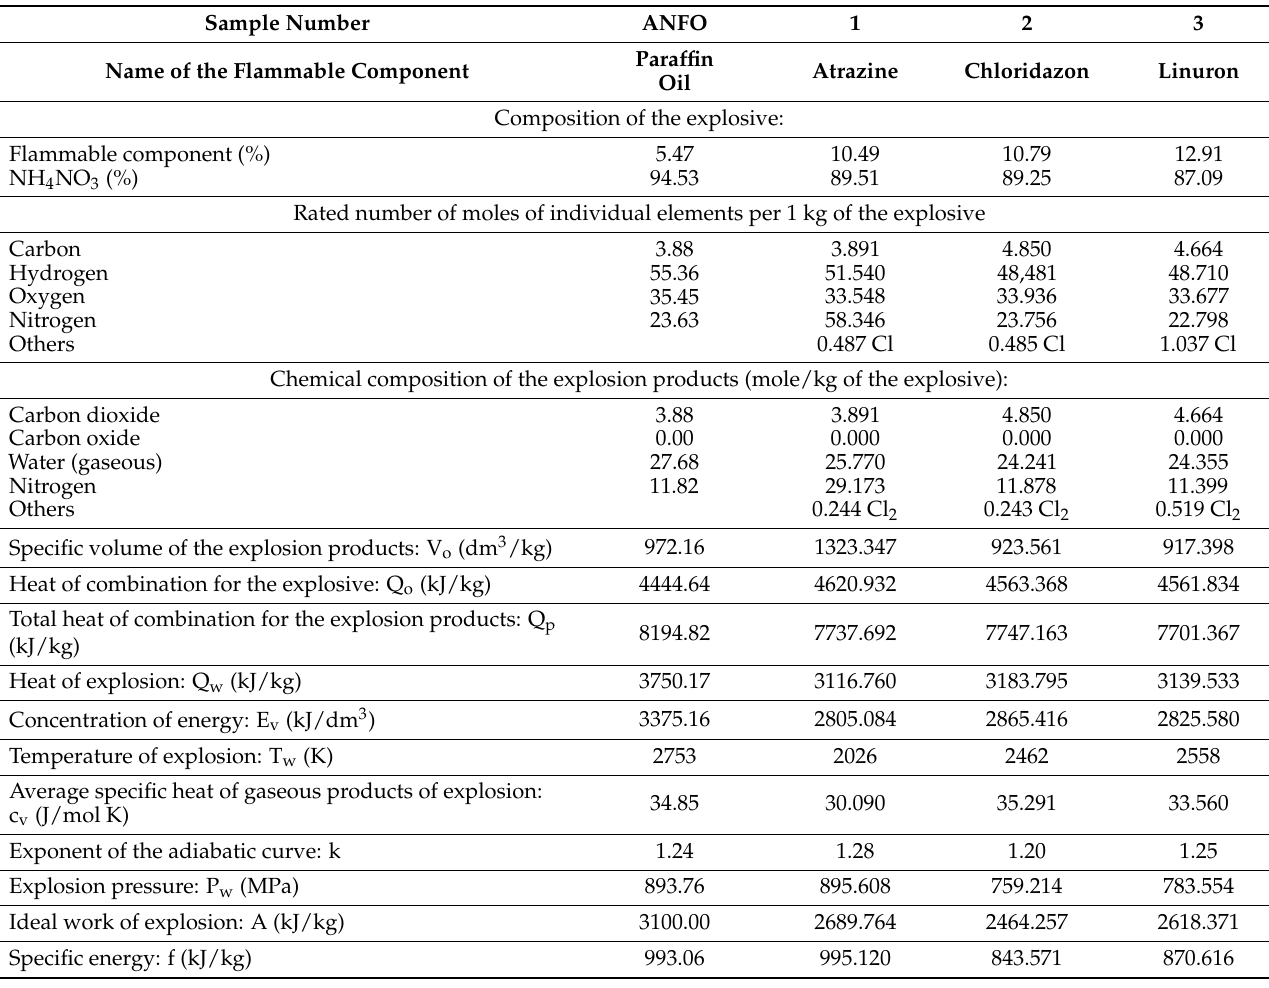
Table 1. Thermodynamic parameters of the explosive blends based on ammonium nitrate and a herbicide